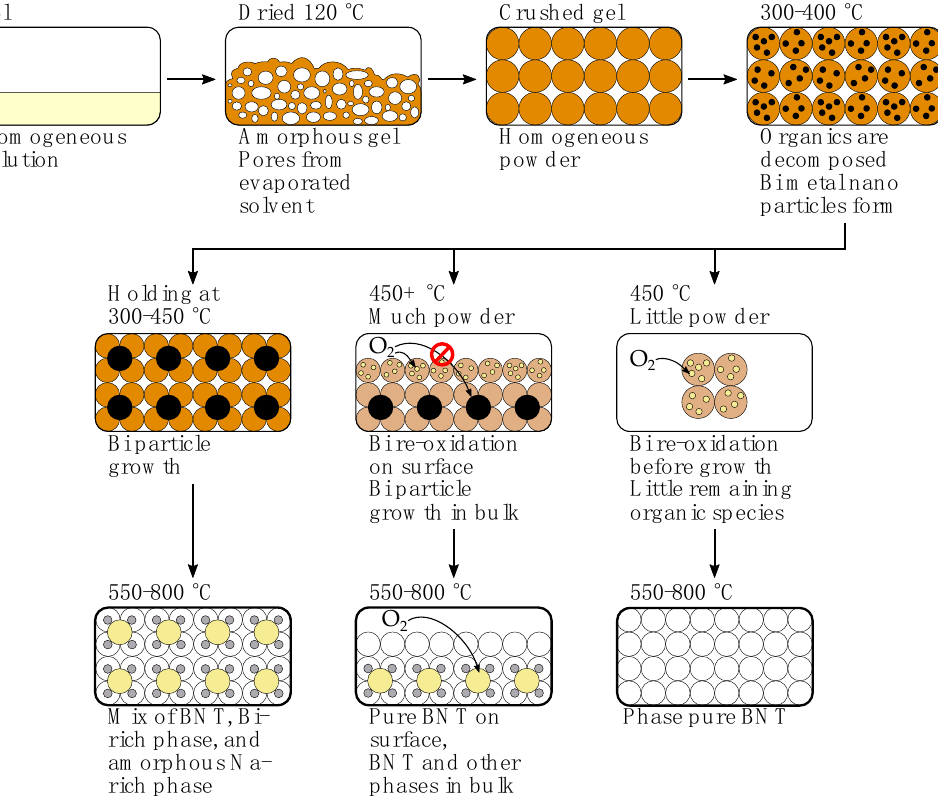
Figure 6. Proposed decomposition process for citrate method powders. In the bottom panels, yellow signifies a bismuth rich secondary phase (e.g., Bi 2 O 3 ), grey signifies an amorphous sodium rich secondary phase invisible to XRD, and white signifies BNT.